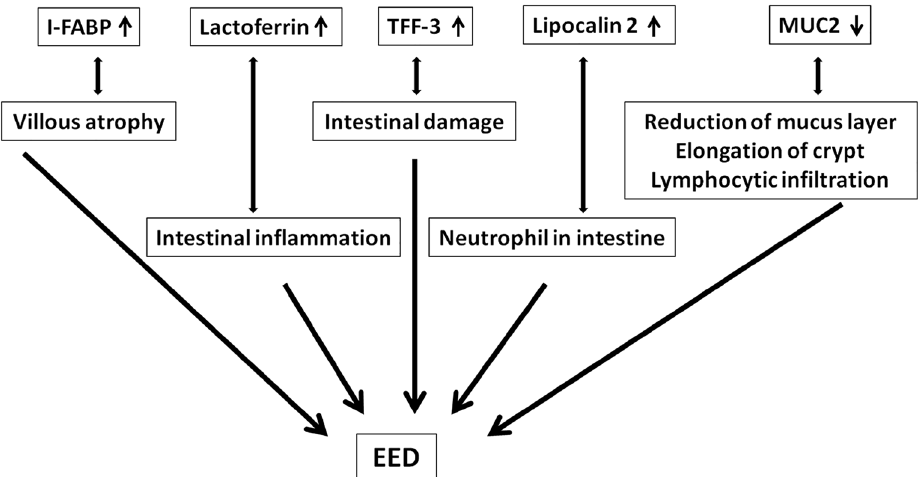
Figure 1. Increased plasma I-FABP is an indication of villous atrophy 35 , increased faecal lactoferrin is an indication of intestinal inflammation 15 , increased plasma TFF-3 suggests intestinal damage 16 and increased faecal lipocalin 2 represents the presence of neutrophil in lamina propria 17 . On the other hand, lower levels of faecal MUC2 describe the reduction of mucus layer, elongation of crypt and lymphocytic infiltration 18 . Overall, all these representations collectively describe the different dimensions of EED and related pathogenesis 1 . In the same way, this entire bio-molecules panel can indicate the presence of